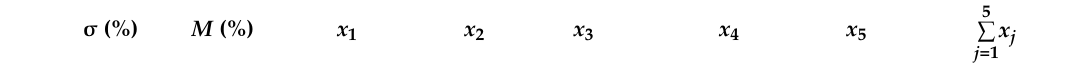
Table 4. Comparison among some fuzzy portfolio